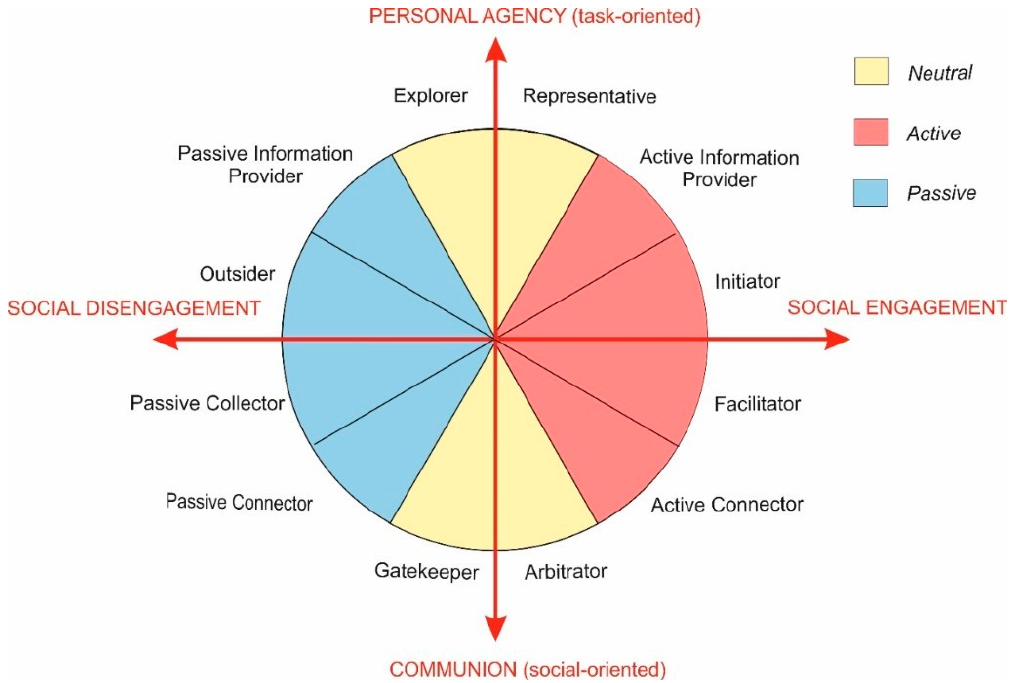
Figure 7. Circumplex of team roles (reproduced from [52] with permission).